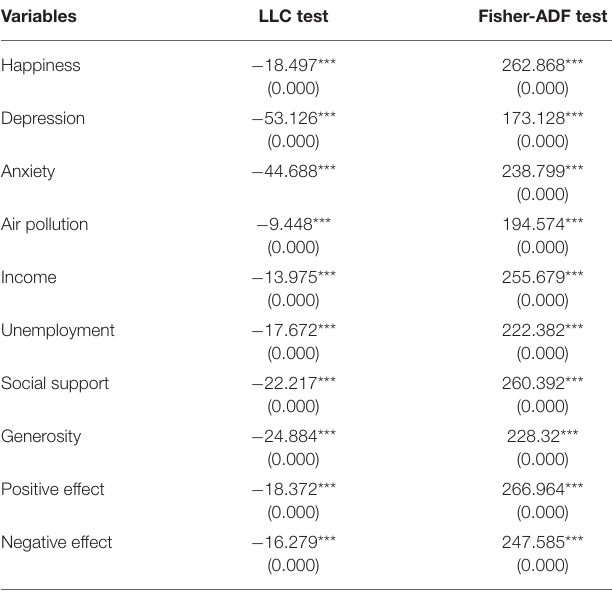
TABLE 3 | Results of the panel unit root